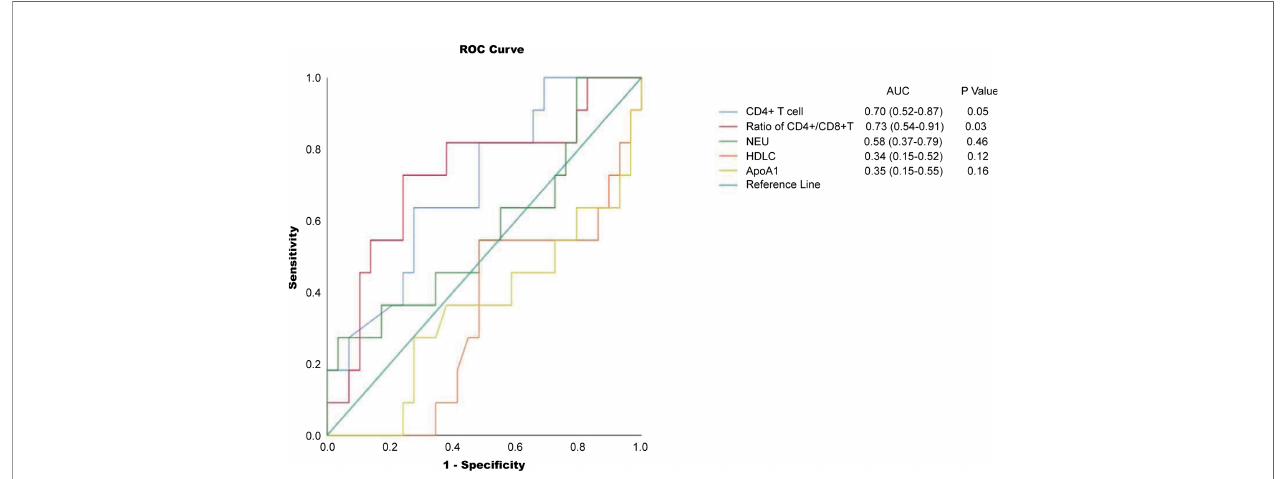
FIGURE 3 | ROC curves for the cutoff points for frequency of CD4+ T cell, ratio of CD4+/CD8+, NEU, HDL, and ApoA1. NEU, neutrophils; HDL, high-density lipoprotein; ApoA1, apolipoprotein A1; ROC, receiver operating characteristic.